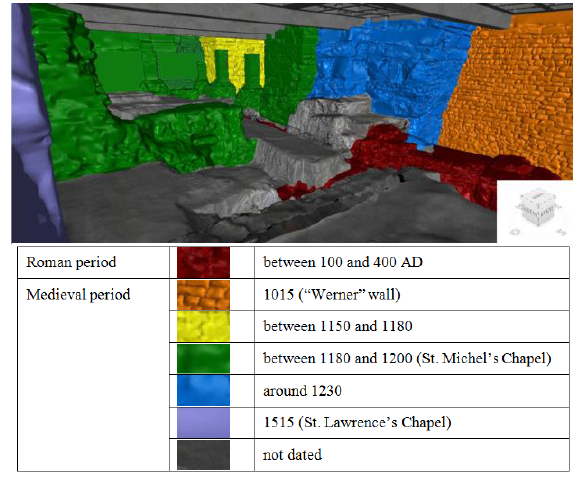
Figure 12. Construction step of the 3D phased model, for a part of the basement of St. Lawrence Chapel, with regard to the archaeological